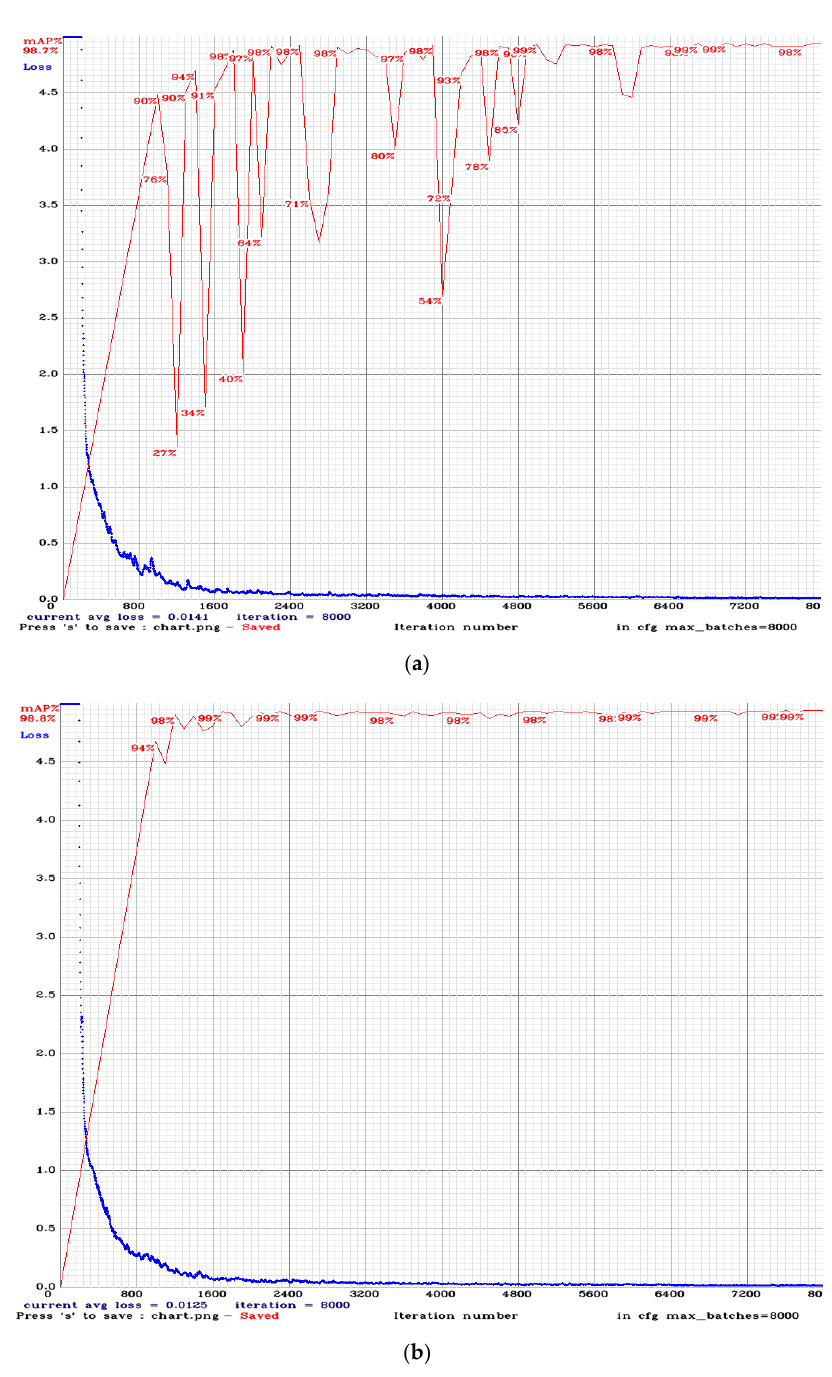
Figure 5. Training loss value, mean average precision (mAP), and average precision (AP) performance for all classes using Yolo V3 ( a ) and Yolo V3 SPP ( b ).